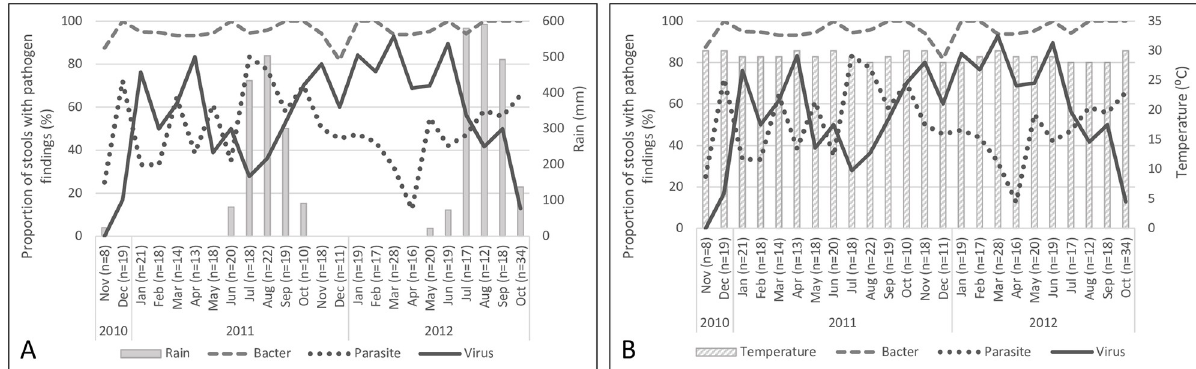
Fig 2. Seasonal variation of diarrhoeal pathogens identified over the 24-month study period with respect to rainfall [4] (A) and temperature (B). Monthly proportions given for those with samples positive for bacterial, parasitic, or viral diarrhoeal pathogens.